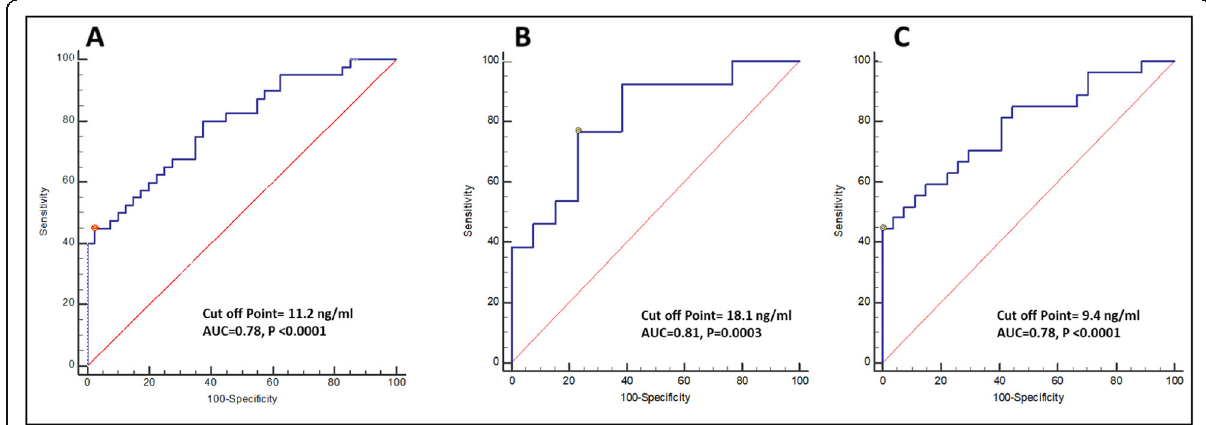
Fig. 2 ROC curve analysis of serum 25(OH)D level that can predict the NAFLD in a all patients, b male patients, and c female